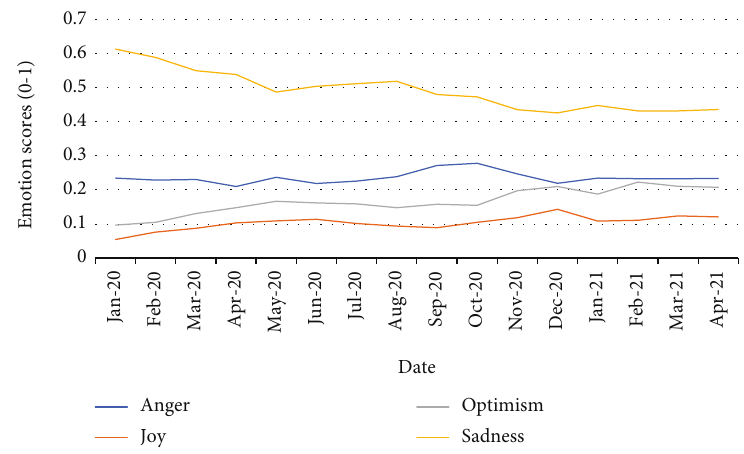
Figure 1: Monthly average emotion scores in the news tweets. Table 3: Frequency of topics in news